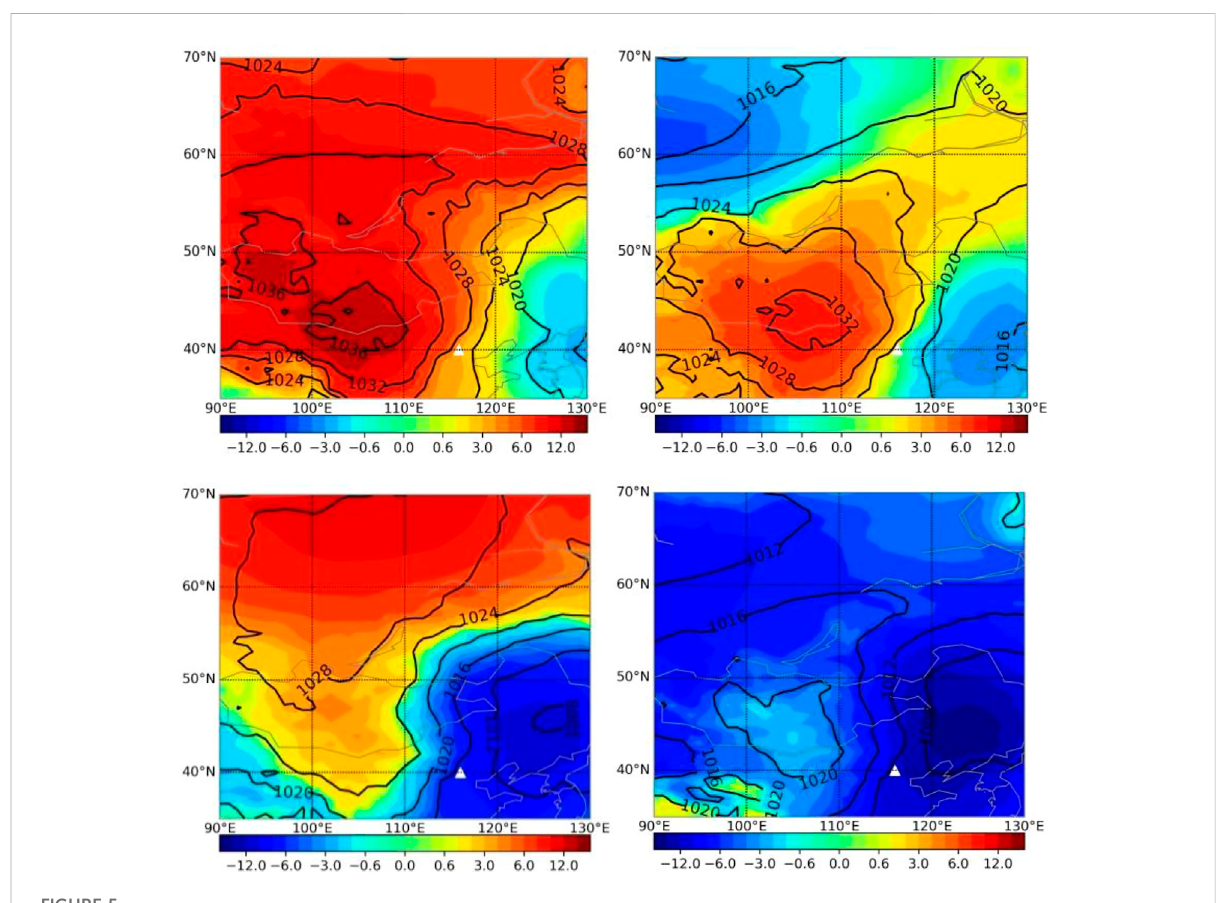
FIGURE 5 Same as Figure 3 except for the sea surface pressure.